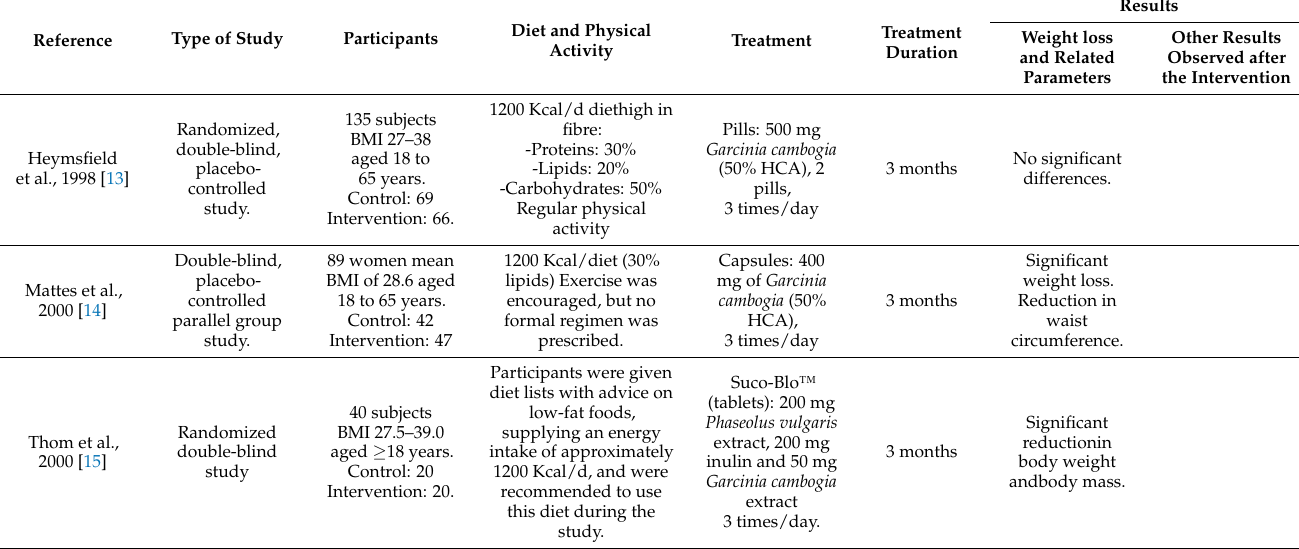
Table 1. Characteristics and results of published intervention studies in